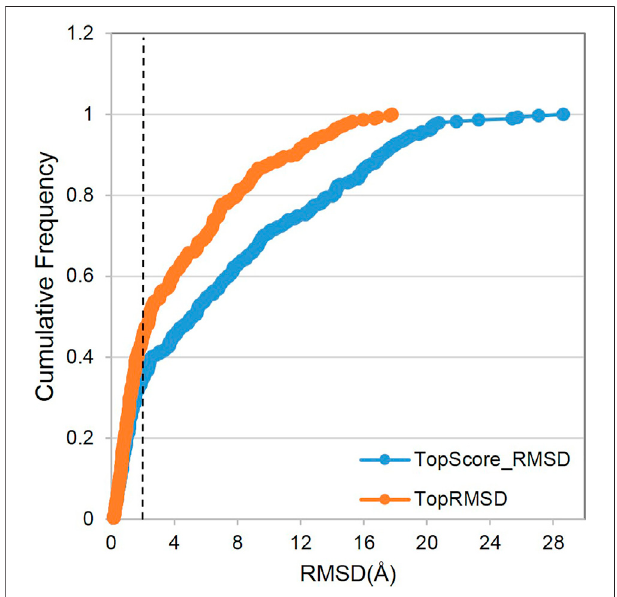
FIGURE 12 | Sample power by comparing cumulative frequencies of TopScore_RMSD and TopRMSD, compared to the methods evaluated in CASF-2016 and